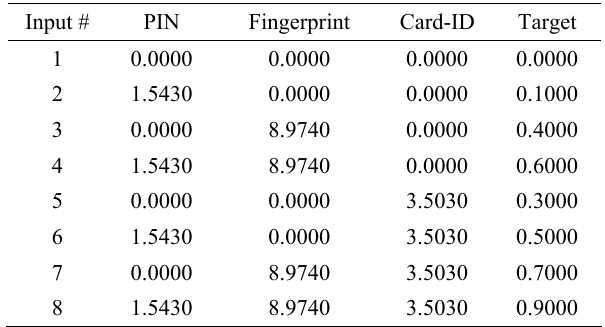
Table 3: Eight combinations of term weight identity attributes metrics input values and the corresponding target